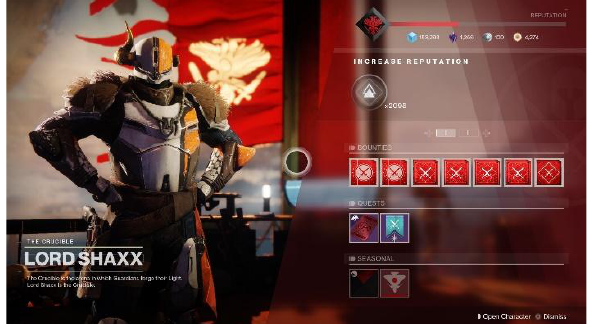
Figure 1. The NPC Lord Shaxx. Destiny 2